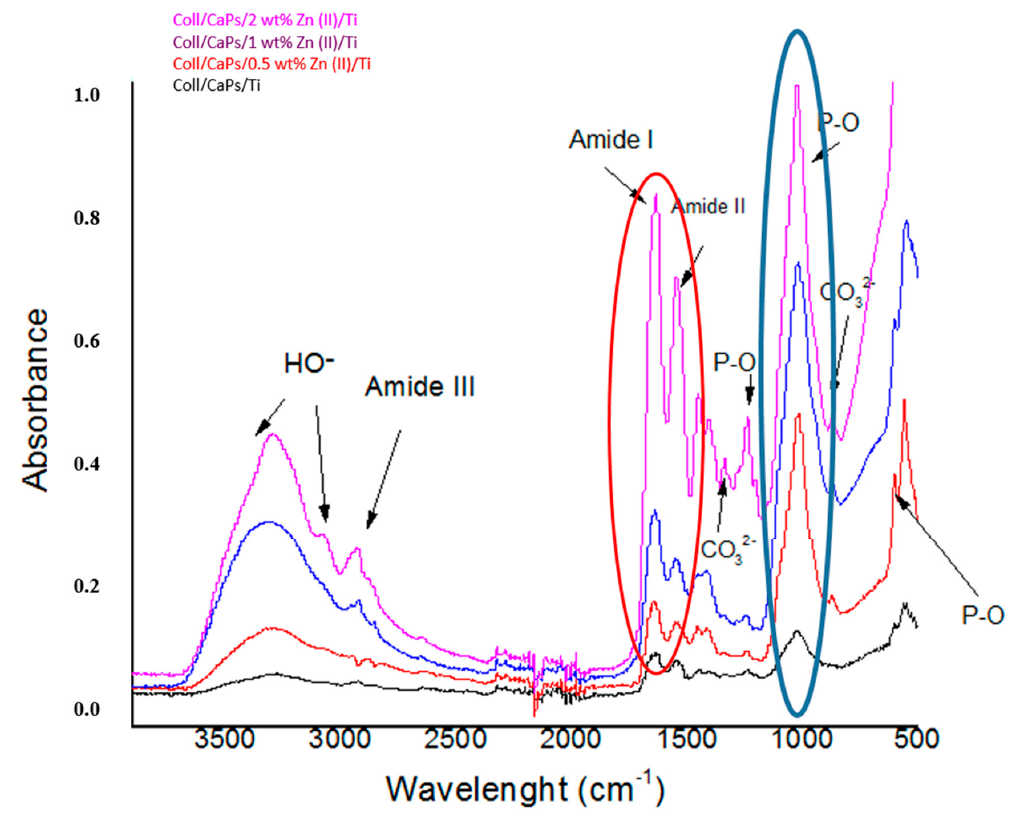
Figure 7. FTIR spectra of the Coll/Zn(II)-CPs thin films deposited by spin coating after 14 days of immersion in SBF.